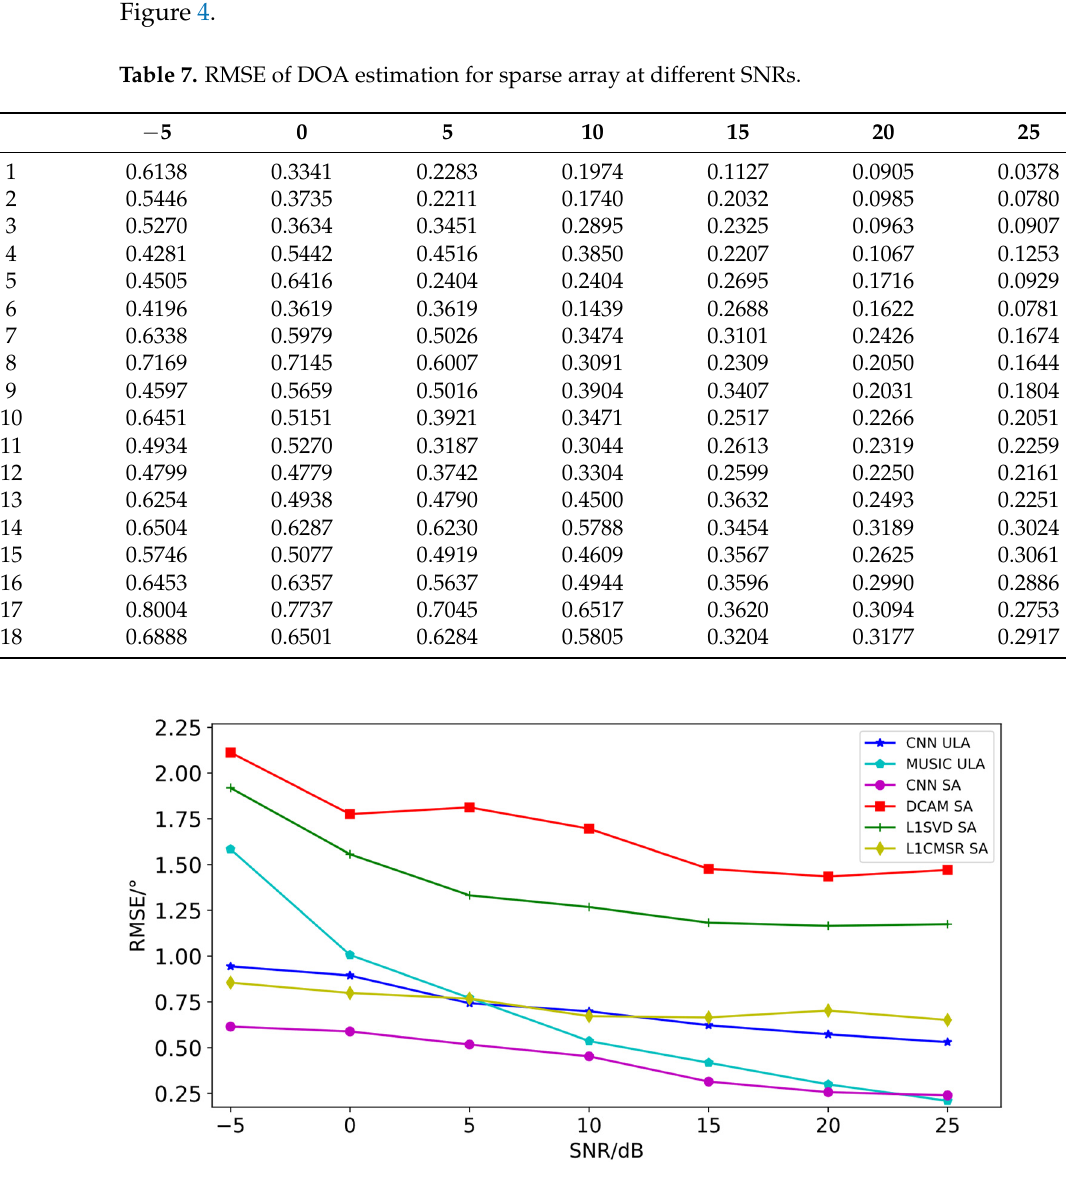
Figure 4. Comparison of RMSE of various algorithms with different SNRs.